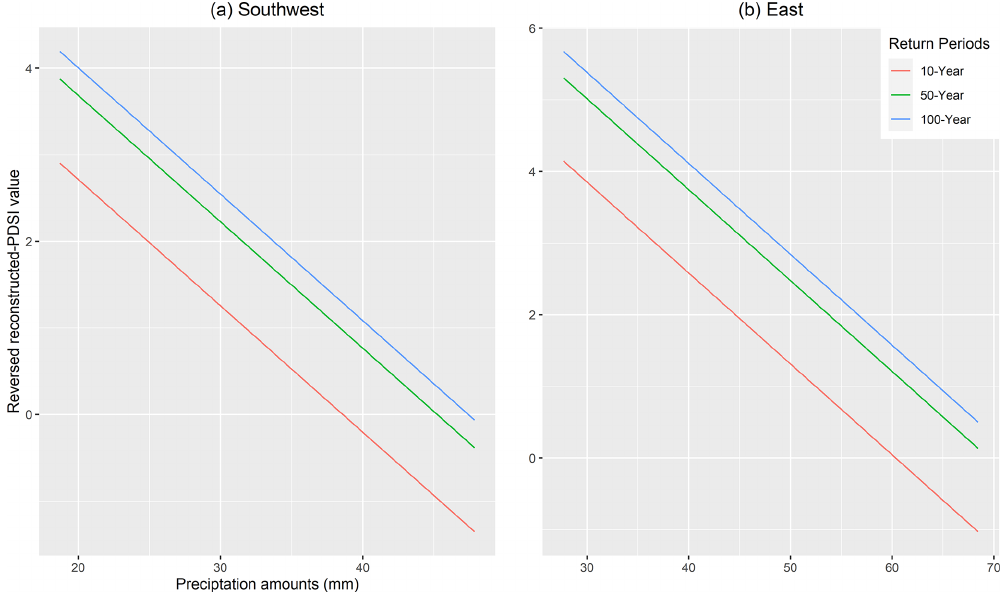
Figure 7. Relationship between precipitation and reversed reconstructed PDSI values in the southwest (a) and the east (b) based on the best GEV model. Since the PDSI values are reversed, the positive values mean drought conditions. The red, blue, and green lines are 10-, 50-, and 100-year events. This shows that less precipitation leads to higher reversed reconstructed PDSI values, meaning more likelihood of